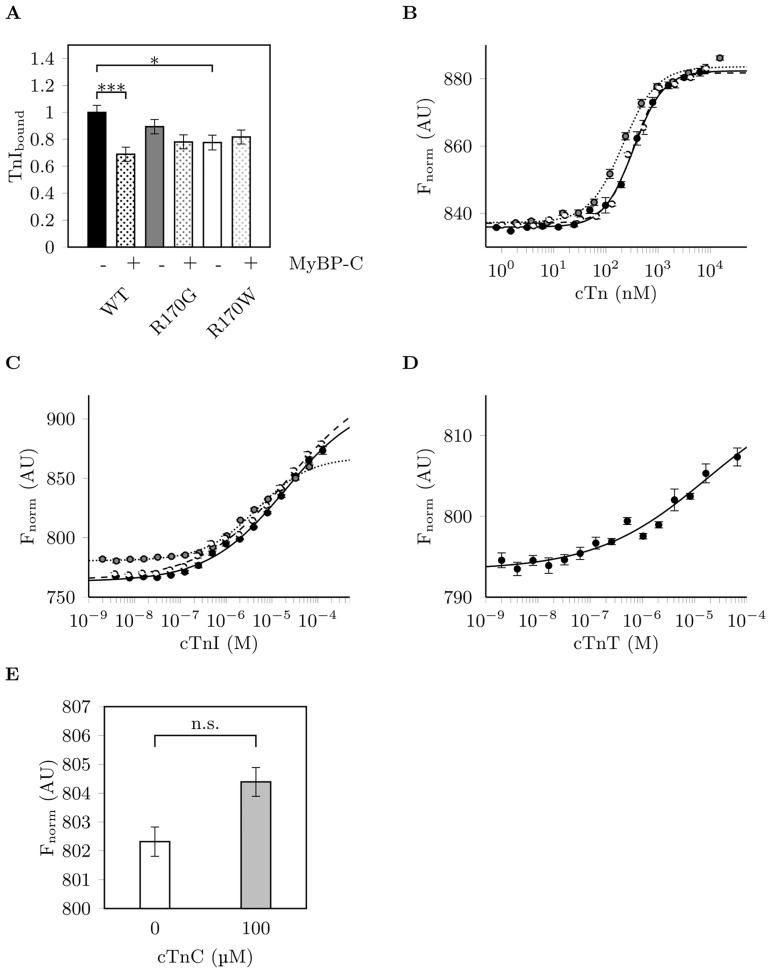
cMyBPC-C0C2 interacts with cTn and impacts its binding to thin filaments.(A) Binding of troponin containing wildtype (WT, black) cTnI or R170G/W (gray or white, respectively) to reconstituted thin filaments depending on the presence of cMyBPC-C0C2 analyzed by cosedimentation. Data are given as amount of bound cTnI relative to total cTnI in the sample ±SEM, normalized to wildtype cTnI in the absence of C0C2 (WT -C0C2, n = 15-18 each, * indicates statistical significance with P<0.05; *** indicates statistical significance with P<0.001). (B) Interaction of cMyBPC-C0C2 with troponin complexes containing cTnI-variants (mean normalized fluorescence ±SEM, AU: arbitrary units; wildtype: solid line, black circles; R170G: dotted line, gray circles; R170W: dashed line, white circles) as measured by MST. Data were fitted to the Hill function to determine EC50 (n = 5 for WT, n = 6 for R170G and R170W each). (C) Interaction of cMyBPC C0C2 with cTnI wildtype or R170G/W (as in panel B, n = 6 for WT, n = 5 for R170G and n = 7 for R170W). (D) Interaction of cMyBPC C0C2 with cTnT (mean ±SEM, n = 5). (E) No significant change in fluorescence (mean ±SEM, n = 4) and thus in cMyBPC thermophoresis was found in the presence of 100 μM cTnC, confirming the absence of an interaction.